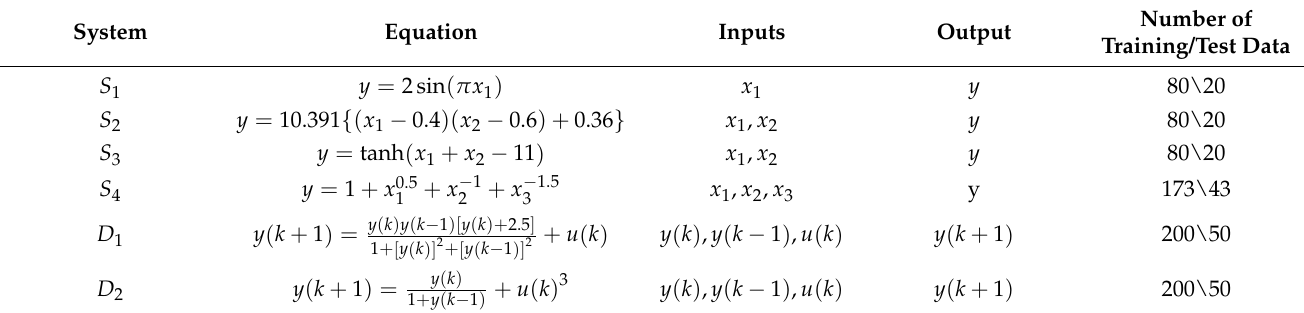
Table 1. Nonlinear systems